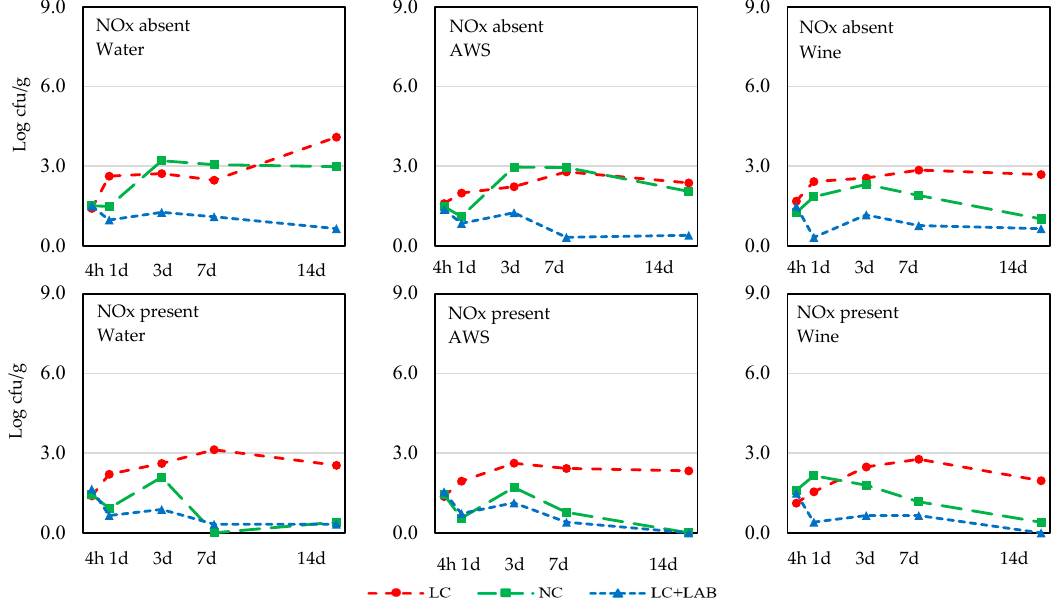
Figure 4. Behavior of L. monocytogenes during incubation of chouriço batter made from low contaminated meat ( LC ), normal contaminated meat ( NC ), and low contaminated meat with LAB added ( LC + LAB ), with or without nitrite plus nitrate (NOx) and water, artificial wine solution ( AWS ), or wine ( n = 4).